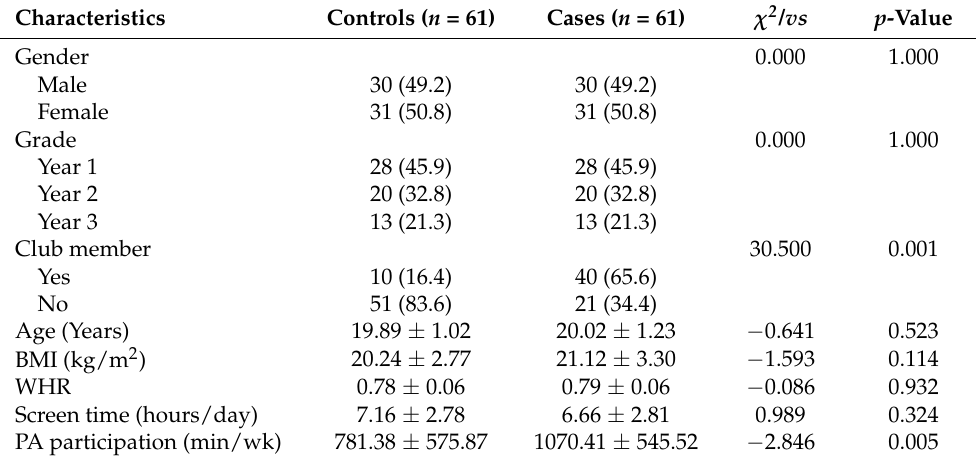
Table 2. Characteristics of physical activity-related injuries (PARIs) cases and non-PARI controls.